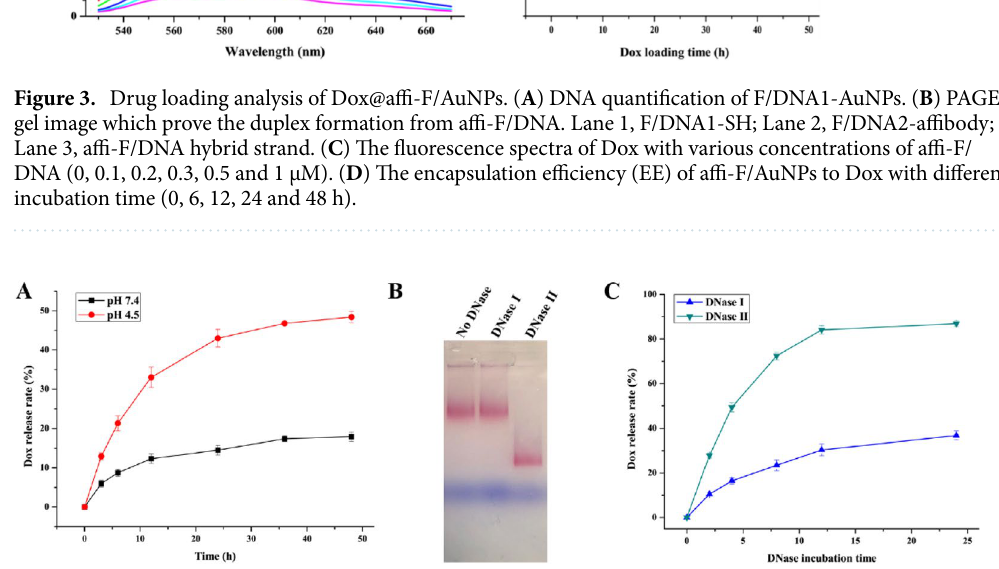
Figure 4. In vitro drug release behavior and nuclease digestion analysis of Dox@affi-F/AuNPs. ( A ) Dox release profile of Dox@affi-F/AuNPs in PBS (pH 7.4) and acetate buffer (pH 4.5). ( B ) Digestion analysis of affi-F/AuNPs by DNase I and DNase II. ( C ) Dox release from Dox@affi-F/AuNPs in DNase I and DNase II